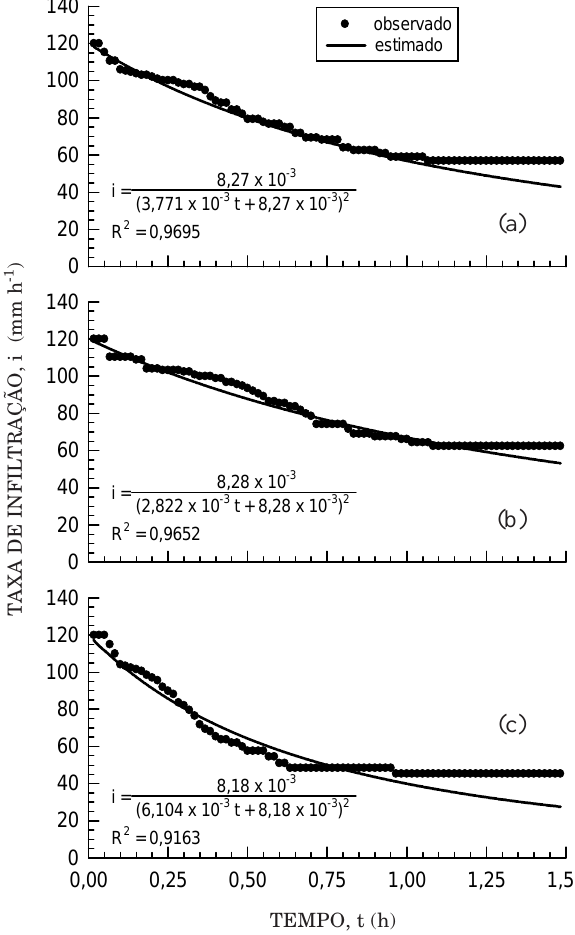
(abril/1995)Figura 3. Taxa de infiltração observada e estimada durante os 90 minutos de chuva simulada para o preparo convencional (a), cultivo mínimo (b) e sistema plantio direto (c), após a semeadura de aveia preta